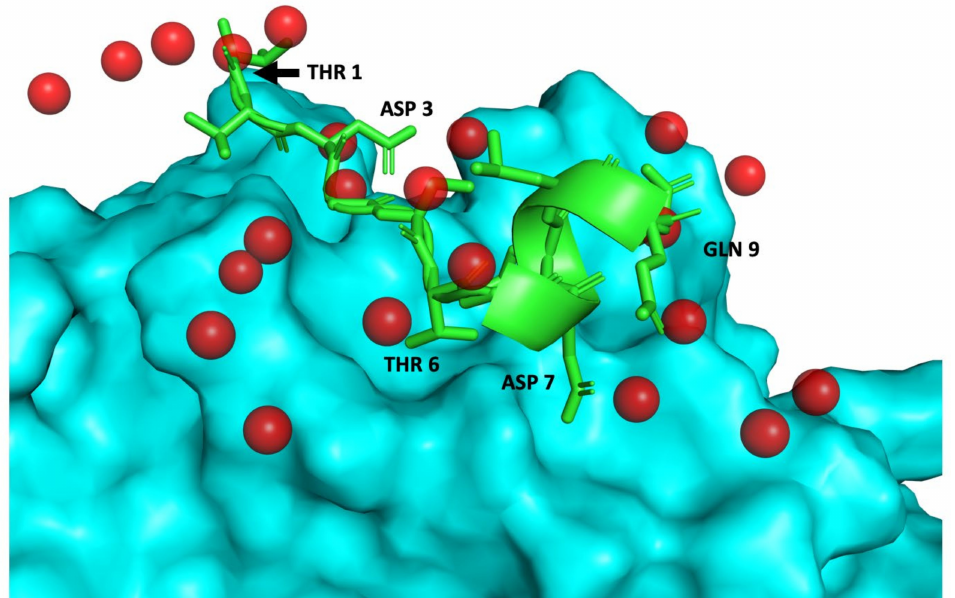
Figure 5. Structural model of PEP43-TWEAK complex. TWEAK and P43 shown in cyan (surface representation) and green (cartoon and stick representation) respectively. Several residues of P43 are shown for reference. Red spheres represent the anchor residues derived from the TWEAK-Antibody structure (PDB code: 4HT1 [24]) used for peptide modelling (see Material and Methods and Supplementary File File1.coord.pdb). The structural rendering of protein and peptides shown in this figure and Figures S4–S6 were done using PyMol